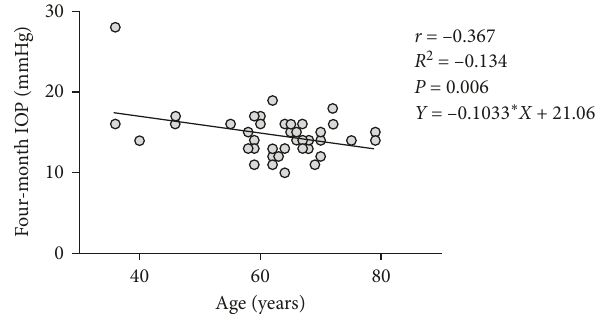
Figure 6: Coefficient of correlation ( r ) and linear regression analysis ( R 2 ) between POAG patients’ years of age and IOP measurement at the four-month follow-up visit. lation coefficients ( r ), 95% CI, and two-tailed P